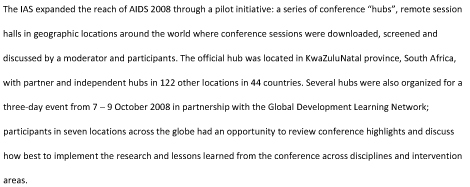
Conference Hubs